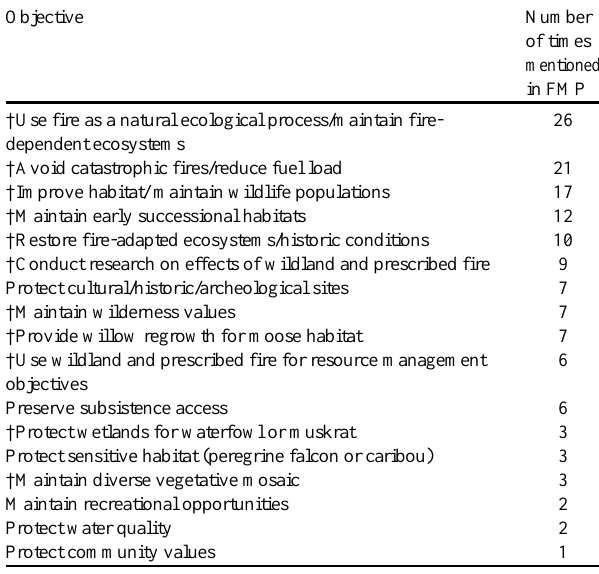
Fig. 9 . Factors affecting wildfire behavior as related by Koyukuk National Wildlife Refuge Fire Management Plan (FMP).